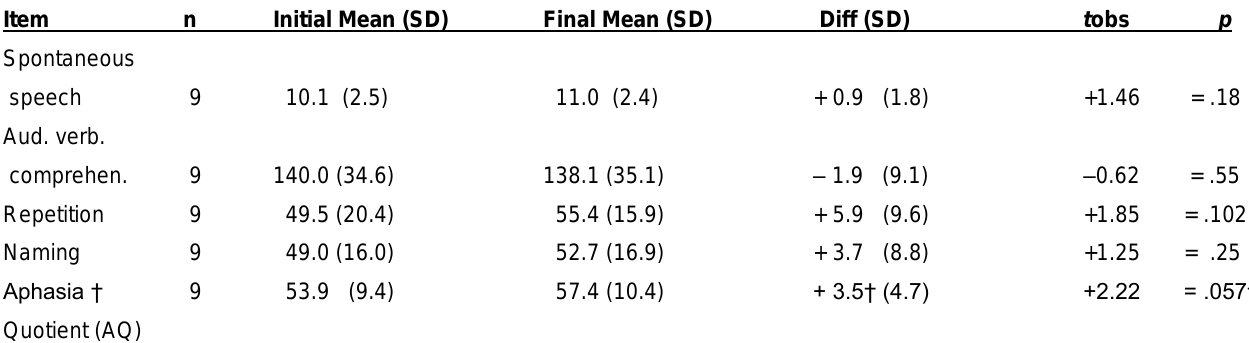
Table 3. WAB-R (Impairment Level) Changes in SCALE Participants with Chronic Aphasia following Remote Therapy & On-line Exercise